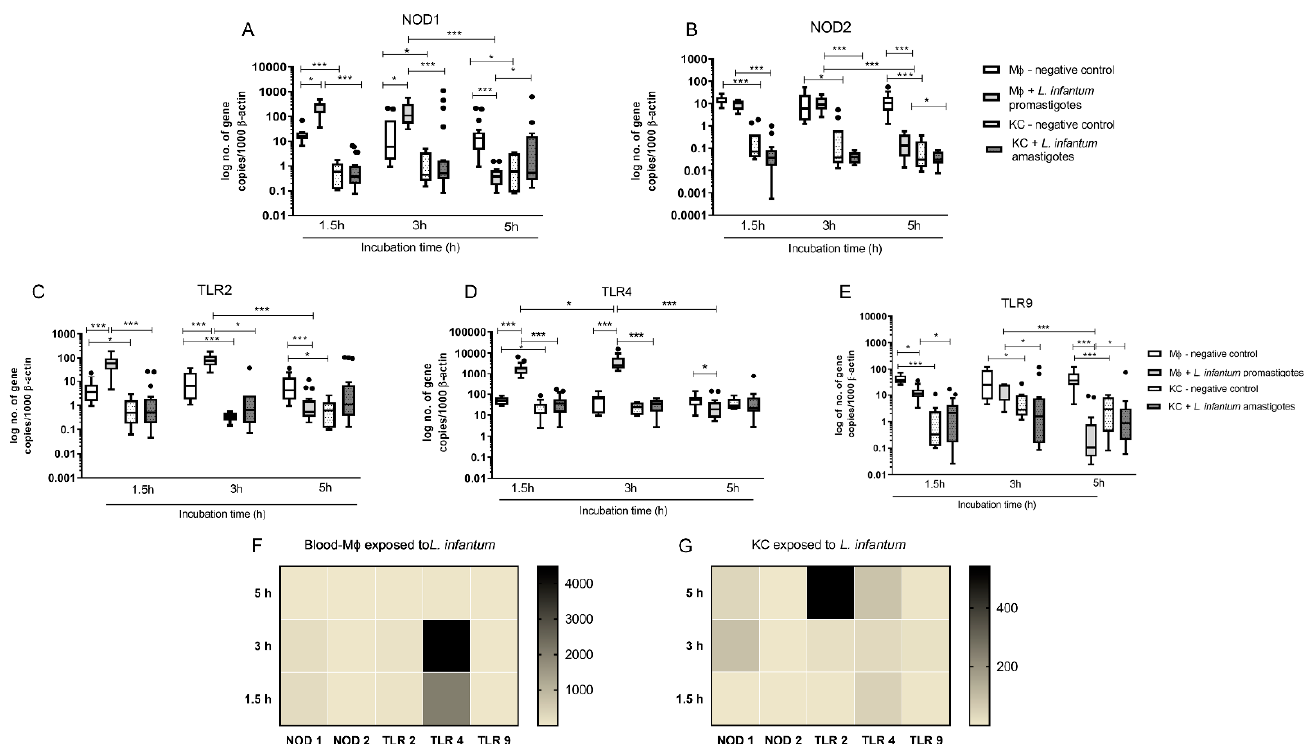
Figure 4. Gene expression of innate immune receptors in L. infantum infected KCs and blood-MØ. Blood-MØs were exposed to promastigotes and KCs to amastigotes. The number of copies of NOD1 ( A ), NOD2 ( B ), TLR2 ( C ), TLR4 ( D ), and TLR9 ( E ) mRNA was determined by real-time PCR at 1.5 h, 3 h, and 5 h of parasite exposure. Results are expressed by whisker box-plot (Tukey). Outlier values are indicated by black dots. The non-parametric Wilcoxon test was used for statistical comparisons ( n = 10). * ( p < 0.05) and *** ( p < 0.0001) indicate significant differences. Heat maps represent the mRNA accumulation of innate sensors by blood-MØs ( F ) and KCs ( G ) during parasite exposure.